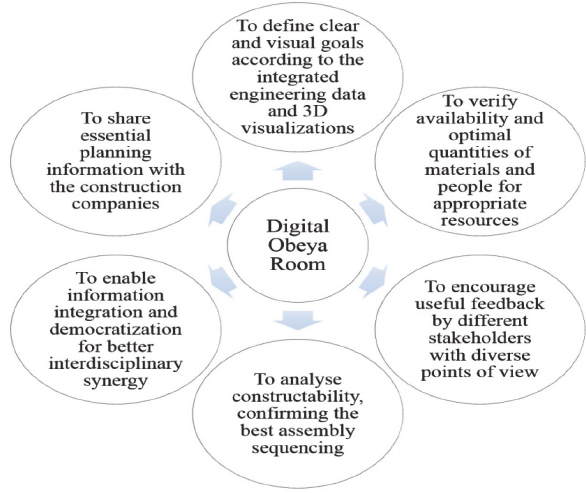
Figure 3. Guidelines in the Digital Obeya Room